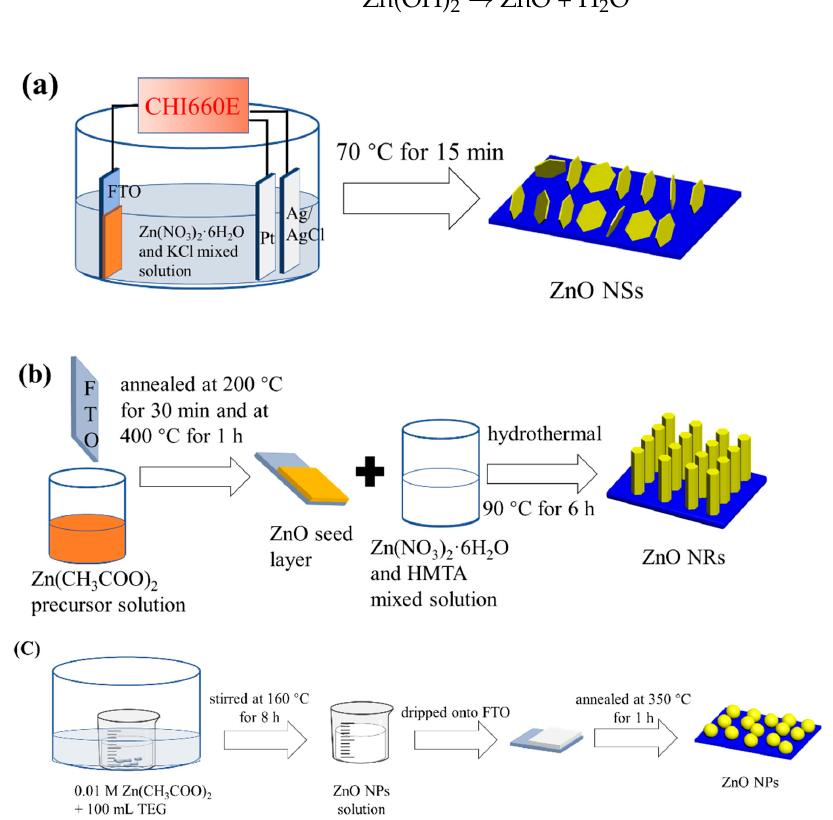
Figure 1. Schematic illustration for the fabrication process of ( a ) ZnO NSs, ( b ) ZnO NRs, and ( c ) ZnO NPs photoanode.